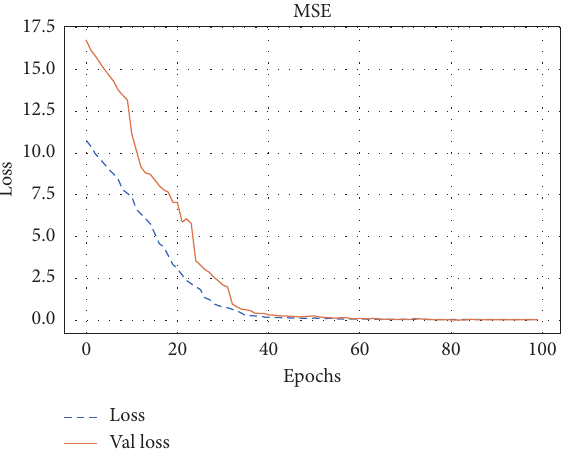
Figure 11: Validation of the model in terms of MSE.